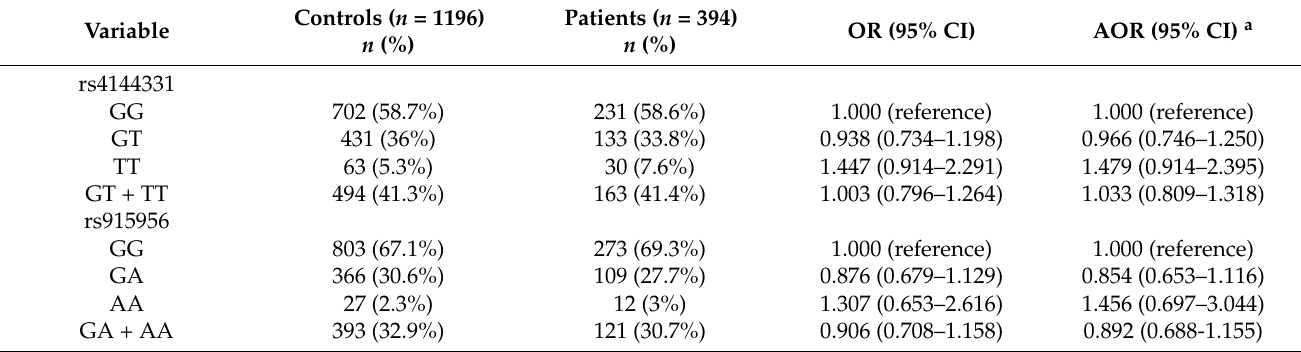
Table 2. Genotyping and allele frequency of TRIM-21 single nucleotide polymorphism (SNP) in HCC and normal controls.